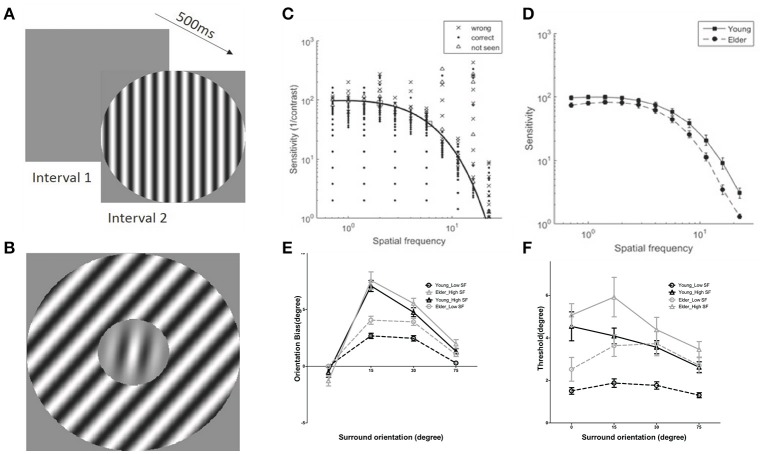
Examples of stimuli used and results of contrast sensitivity function and tilt illusion measures. (A) Schematic illustration of the contrast sensitivity function (CSF) measure; (B) Example of stimuli in tilt illusion measure. (C) Examples of results of CSF measures and fits in the 2-Alternative unforced Choice (2AuFC) design; squares depict the two chosen SFs for the subsequent tilt measures; (D) Averaged values of contrast sensitivities at the 11 different SFs measured for older adults and younger groups; (E) Tilt illusion results, indicated by orientation bias necessary to perceive the center as vertical, as a function of SOs and SFs (low-SF: circles; high-SF: triangles) for older adults (gray) and younger (black) groups; negative (positive) deviations for negative (positive) surround orientations correspond to repulsion; (F) Orientation thresholds around perceived verticality.